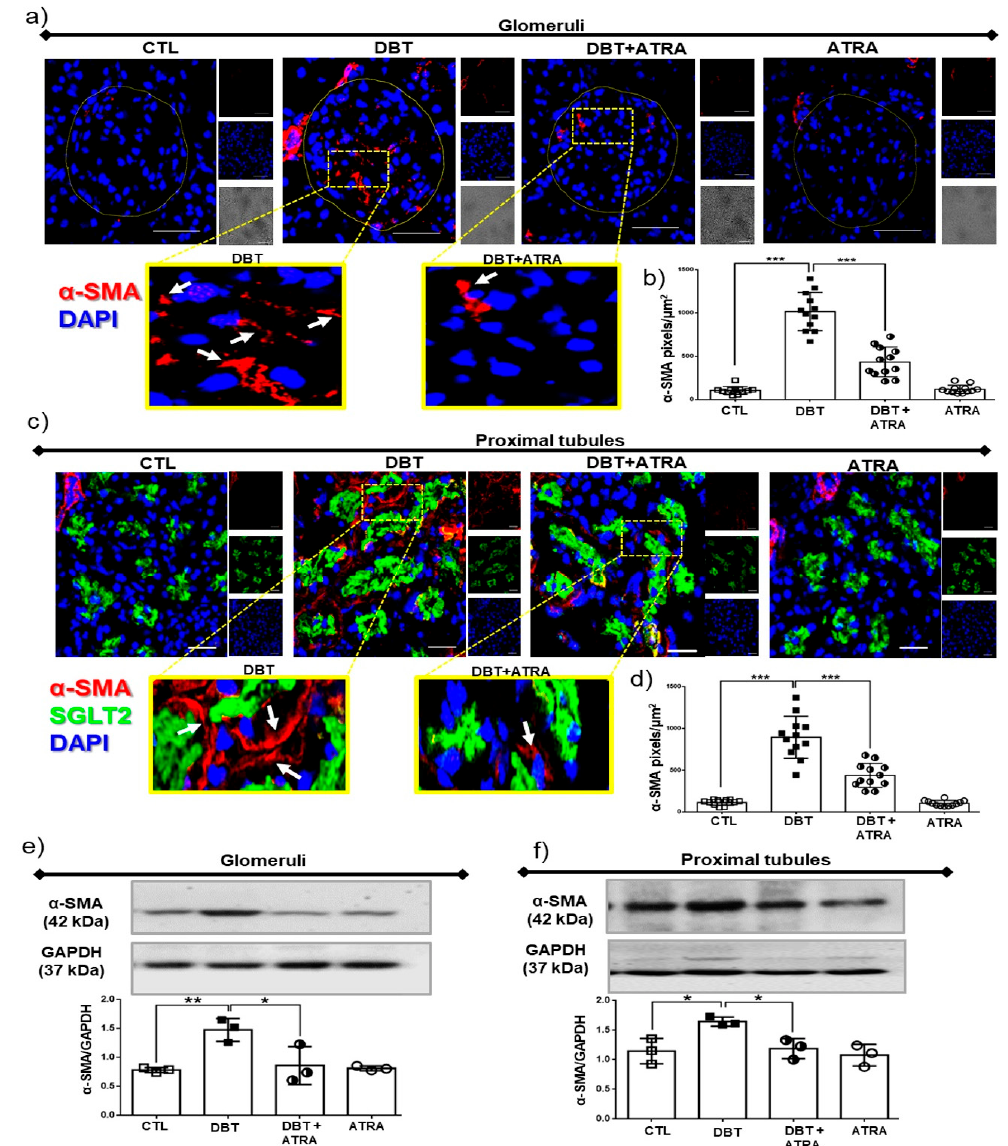
Figure 4. All-trans retinoic acid (ATRA) treatment decreased fibrogenic factors in early-stage diabetic nephropathy (DN). Confocal immunofluorescence for alpha-smooth muscle actin ( α -SMA, marker of myofibroblasts) in renal tissue. ( a ) Representative microscopy images of α -SMA positive cells